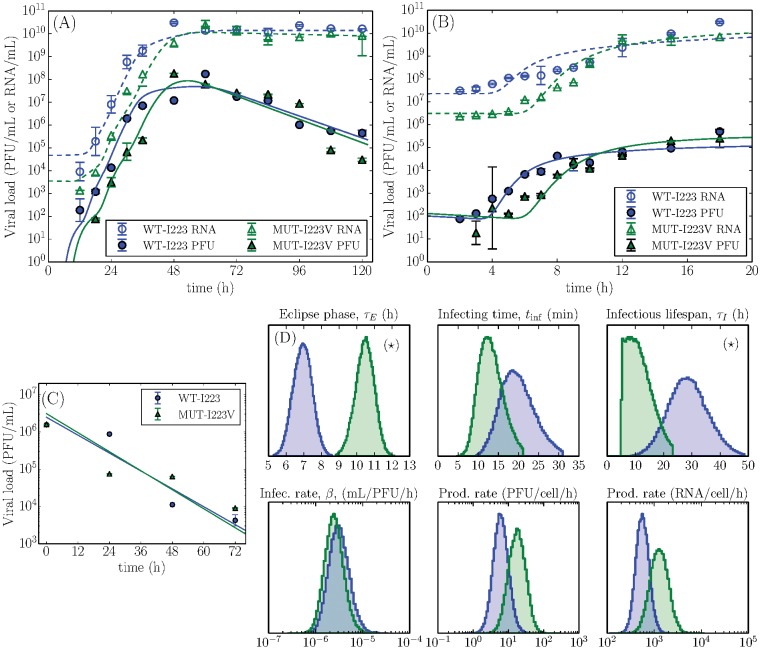
Experimental data and extracted parameters characterizing virus replication fitness.Measured H1N1pdm09 WT-I223 (blue circles) and MUT-I223V (green triangles) viral load concentrations for the (A) multiple-cycle, (B) single-cycle, and (C) mock-yield assays. The points represent the geometric mean and their error bars correspond to the standard deviation of the experimental data points collected in triplicate at each time point. The lines were produced using Eq (1) with the median parameter values presented in Table 1 solved as described in Methods. (D) Probability density functions of the key virus replication parameters with statistically significant differences indicated with a (⋆).